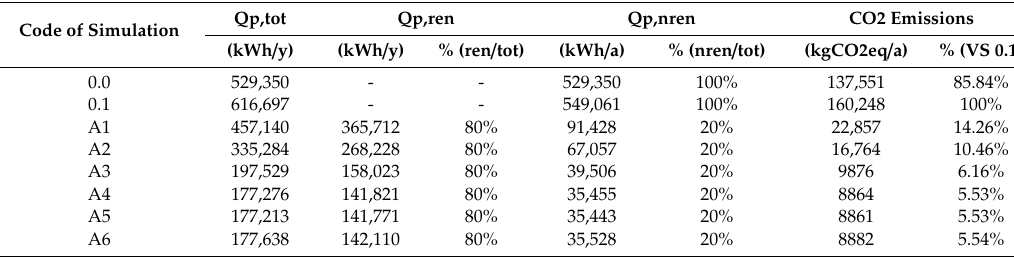
Table 9. Oulx energy simulation